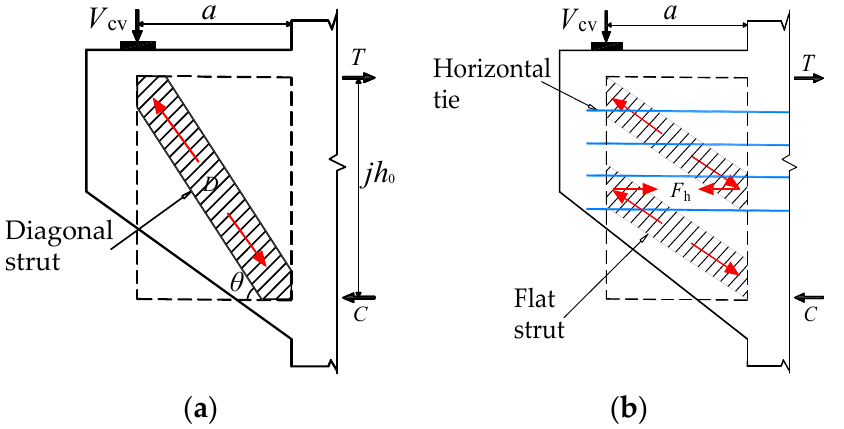
Figure 4. Corbels shear-resisting mechanisms: ( a ) diagonal mechanism; ( b ) horizontal mechanisms. The value of the inclination θ (Figure 4a) between the diagonal strut and the